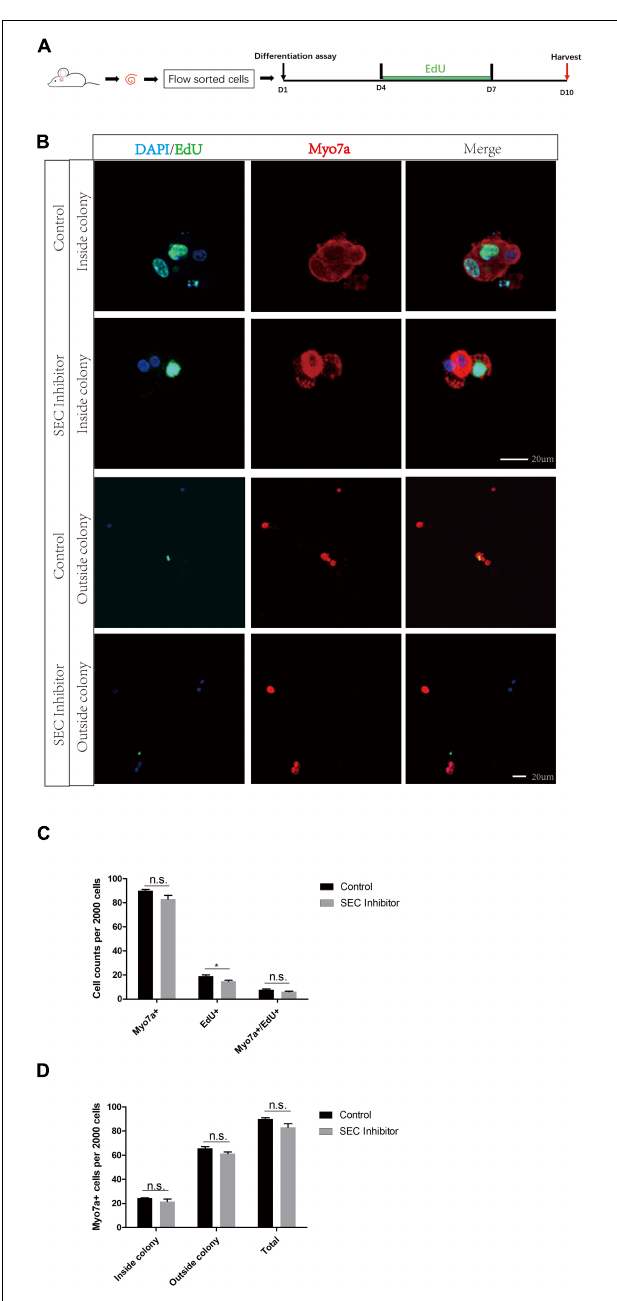
FIGURE 5 | The differentiation assay of Lgr5+ cells after inhibition of the super elongation complex (SEC). (A) Schematic of the differentiation assay. The cochleae of neonatal Lgr5-EGFP-CreER mice were trypsinized for FAC sorting, and the sorted Lgr5+ progenitors were cultured in vitro for 10 days with or without 10 µ M flavopiridol. EdU was added during day 4–7 to label proliferating cells. (B) Immunofluorescence images of colonies and single cells formed from Lgr5+ progenitors with 10 µ M flavopiridol added as the SEC inhibitor. DMSO was used as the control treatment in the Control group. Myo7a and Sox2 were used to label hair cells (HCs) and supporting cells (SCs), respectively, and EdU was used to label proliferating cells. Scale bar = 20 µ M. (C,D) Quantification of the total numbers of Myo7a+ and EdU+ cells (C) and the number of Myo7a+ cells inside and outside the colonies (D) . n = 3. n.s., not significant. * P <